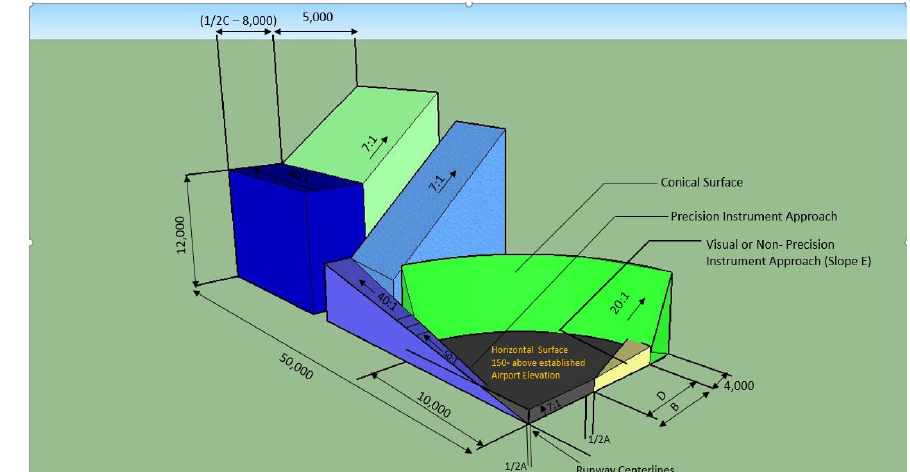
Figure 1. Defining aerial zones defined for airports, which are adapted from [60]. The lower right is the region of relevance for photovoltaics (PV) systems. The primary surface is a surface longitudinally centered on a runway shown in blue, a horizontal plane 150 ft. above the established airport elevation is shown in dark grey, and the conical surface is shown in